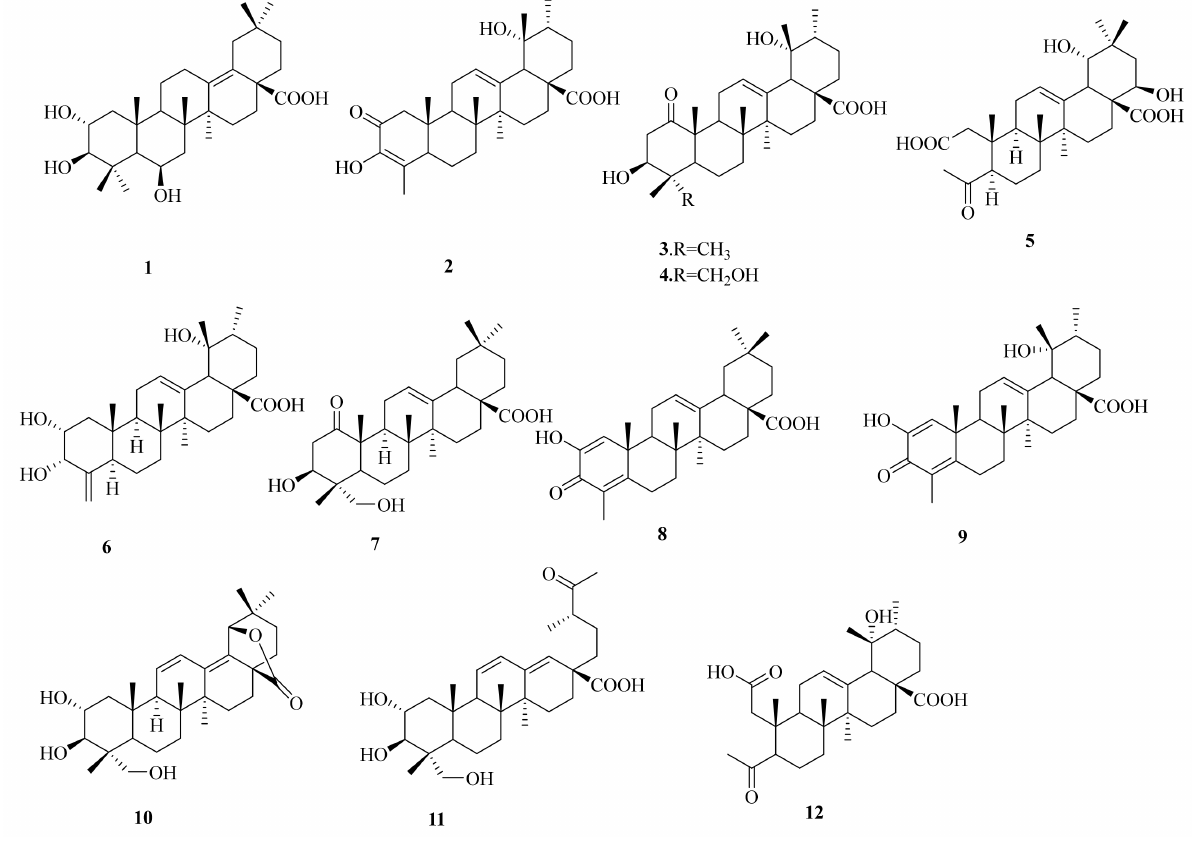
Figure 1. Structures of triterpenoids 1 – 12